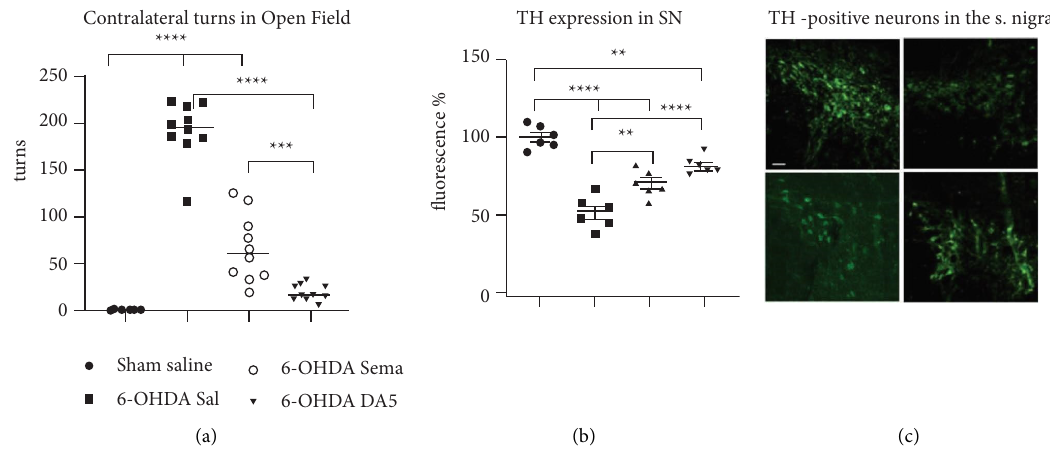
Figure 2: Apomorphine-induced circling and histology of the SN. Animals received apomorphine i.p. (0.05 mg/kg body weight). After 10 min of injection, the rats were placed in an open-feld arena, and their activity was recorded for 30 min. (a) Contralateral turns of apomorphine-induced rotation (means and SEM shown, N � 10 per group; one-way ANOVA followed by Tukey comparisons test). (b) Quantifcation of TH labeling in the SNpc. Te fuorescence of the sham group was set to 100%. ∗∗ � p < 0 . 005; ∗∗∗ � p < 0 . 001; ∗∗∗∗ � p < 0 . 0001. N � 6 per group. (c) Representative fuorescence microscopy images of TH staining in the substantia nigra (scale bar � 50 μ m). Top left panel: Sham control; top right panel: 6-OHDA + Sal; lower left panel: 6-OHDA + Sema; lower right panel: 6- OHDA +